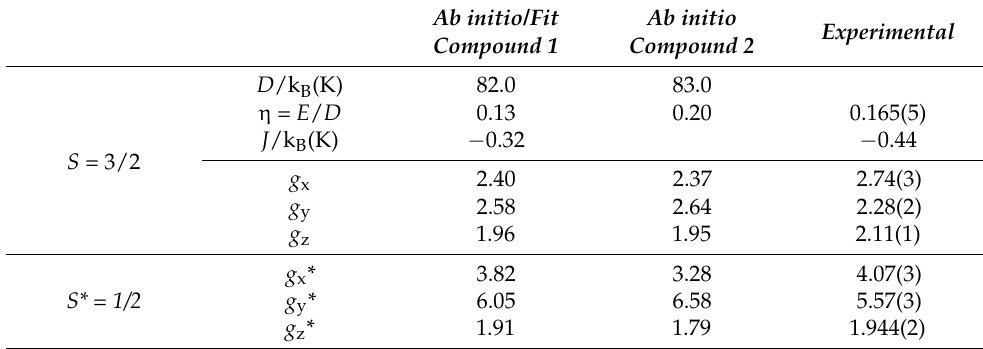
Table 2. Summary of parameters of single-ion ZFS Hamiltonian given by Equation (1). ab initio and ground state KD1 g *-factors. experimental, together with S * = 1 2